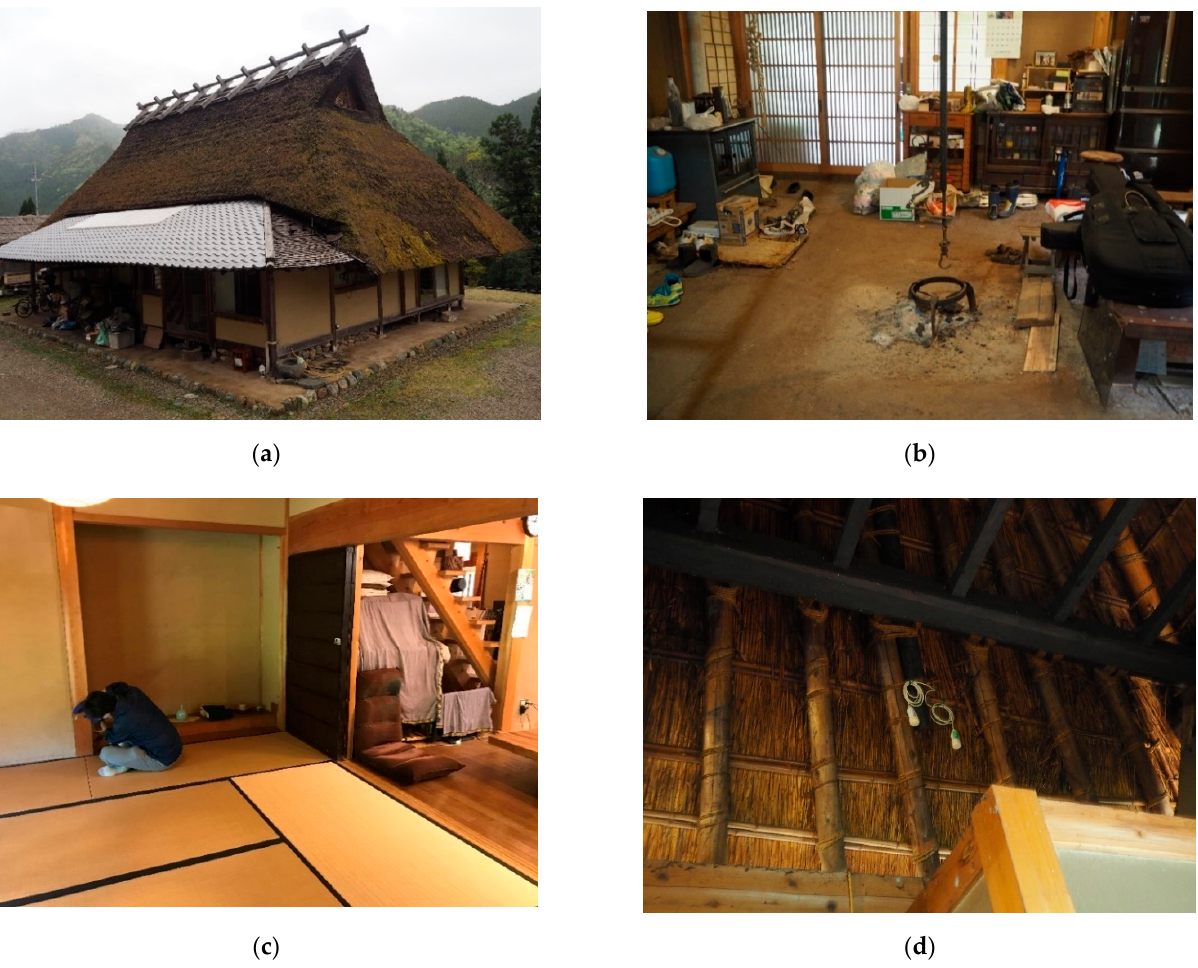
Figure 1. Photographs of ( a ) the subject house, ( b ) the earth floor space, ( c ) the Japanese-style room and dining room, and ( d ) underside of the thatched roof.